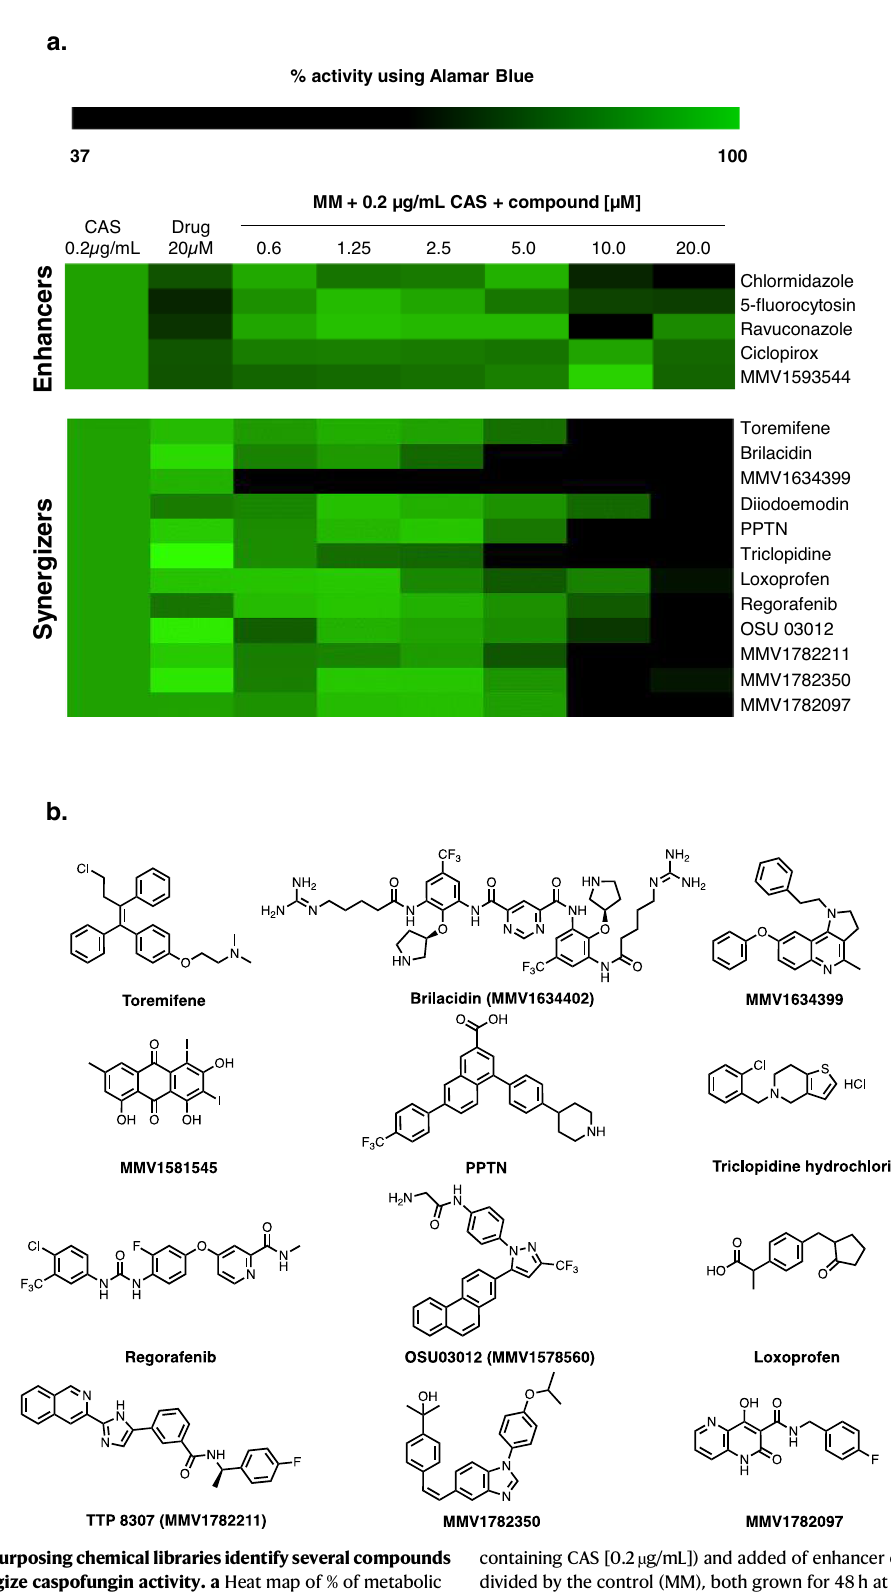
containing CAS [0.2 µ g/mL]) and added of enhancer or synergizers [0.6 – 20 µ M] divided by the control (MM), both grown for 48h at 37°C. The results are the average of three independent experiments analyzed in technical duplicates each. Heat map scale and gene identities are shown. b Chemical structures of the CAS